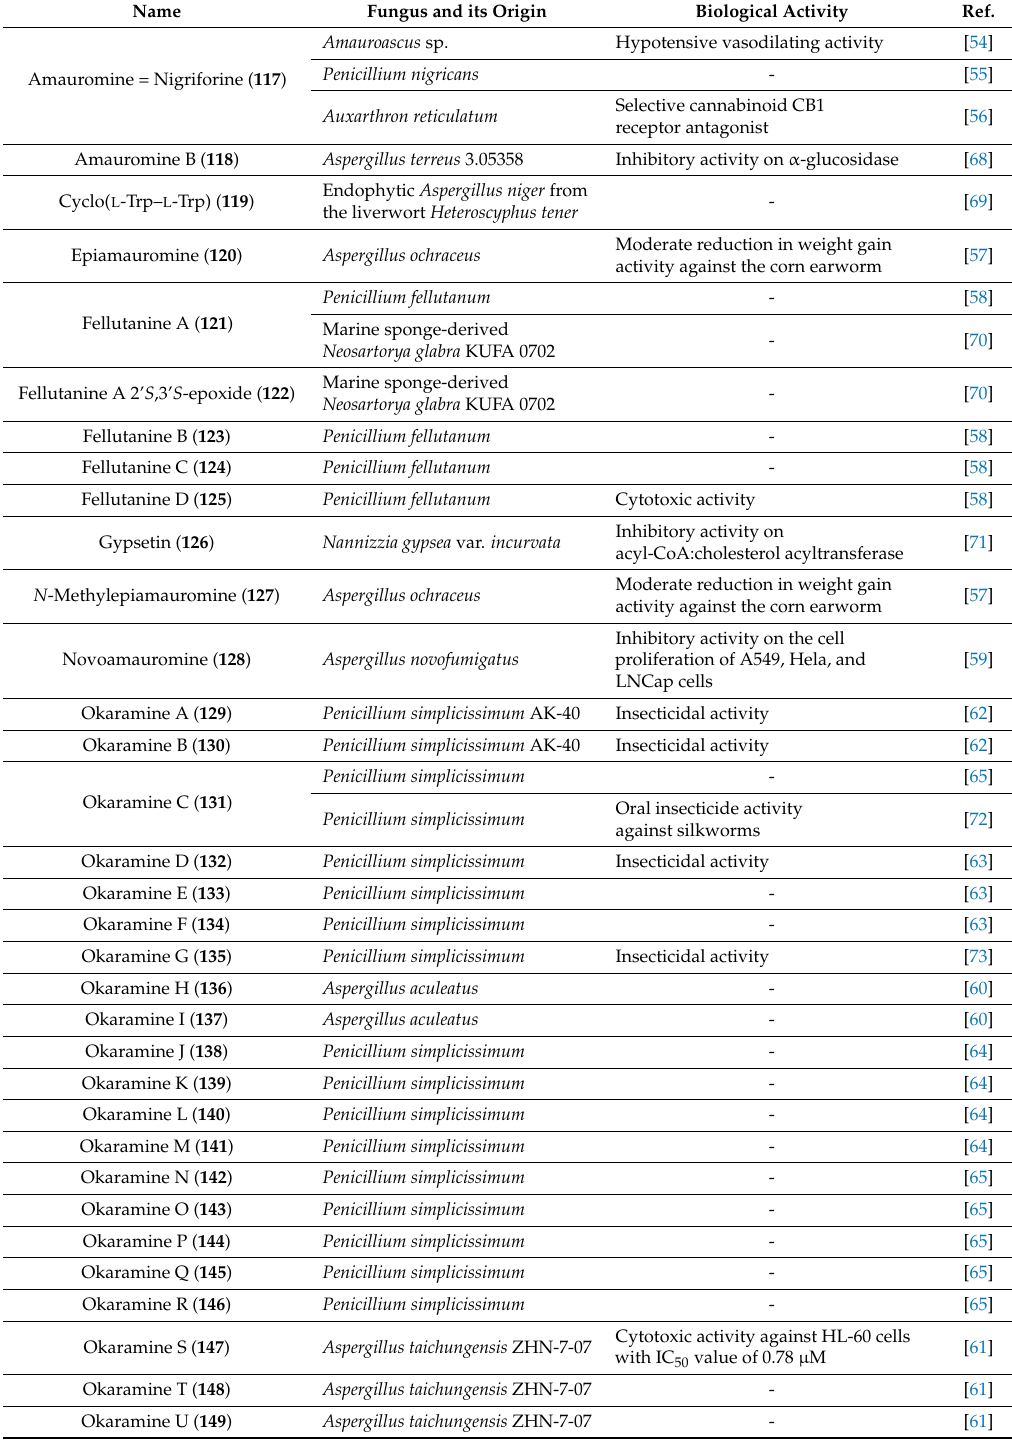
Table 2. Fungal tryptophan-tryptophan cyclodipeptide analogs and their biological